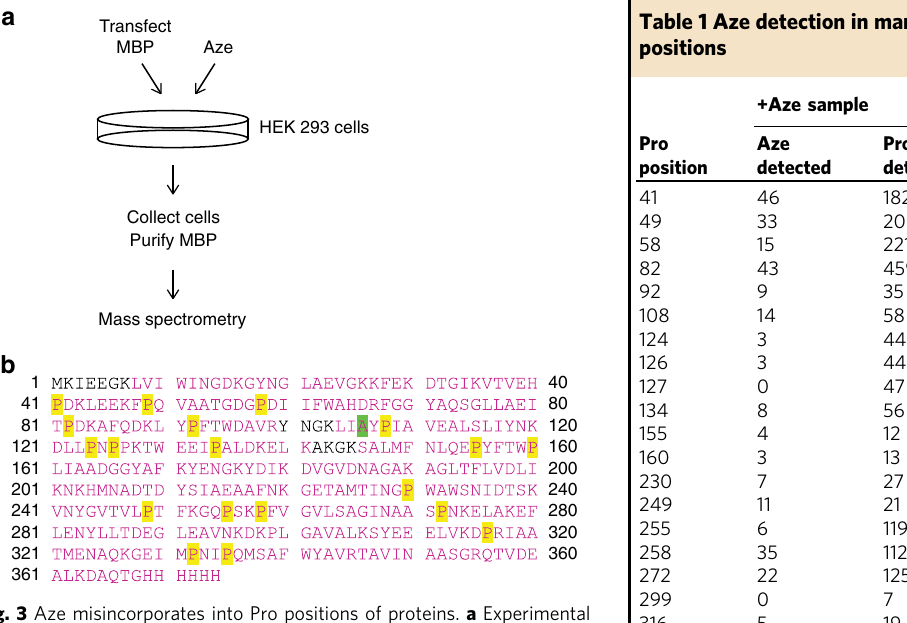
Table 1 Aze detection in mammalian cell puri fi ed MBP at Pro